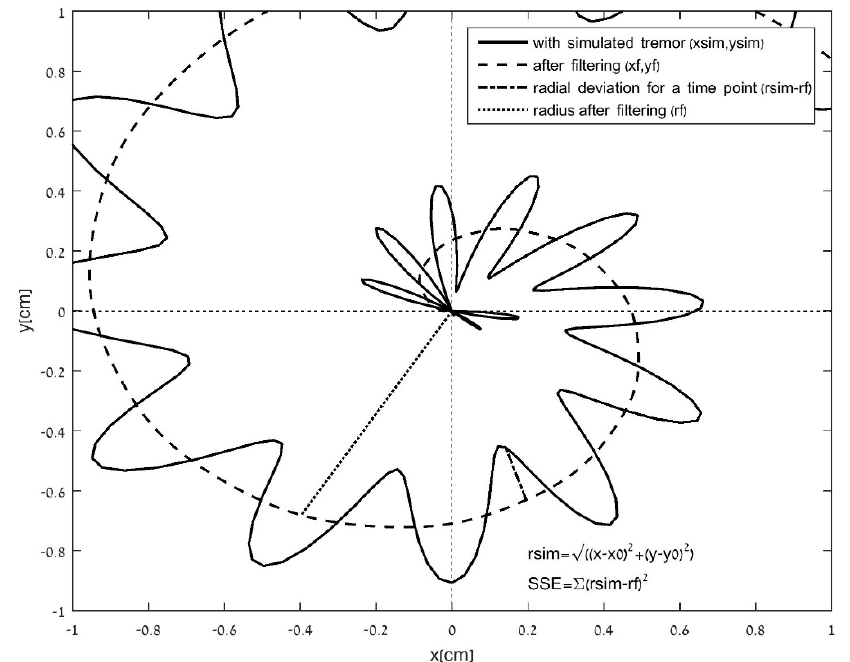
Figure 2. A 1 cm × 1 cm window of a simulated spiral, with an added radial tremor of 7 Hz and a 4 Hz cut-off filtered signal. Deviation of the spiral radius from the radius of the curve after filtering is computed as the normalized sum of square radial deviations of all points (spiral outcome measure b).